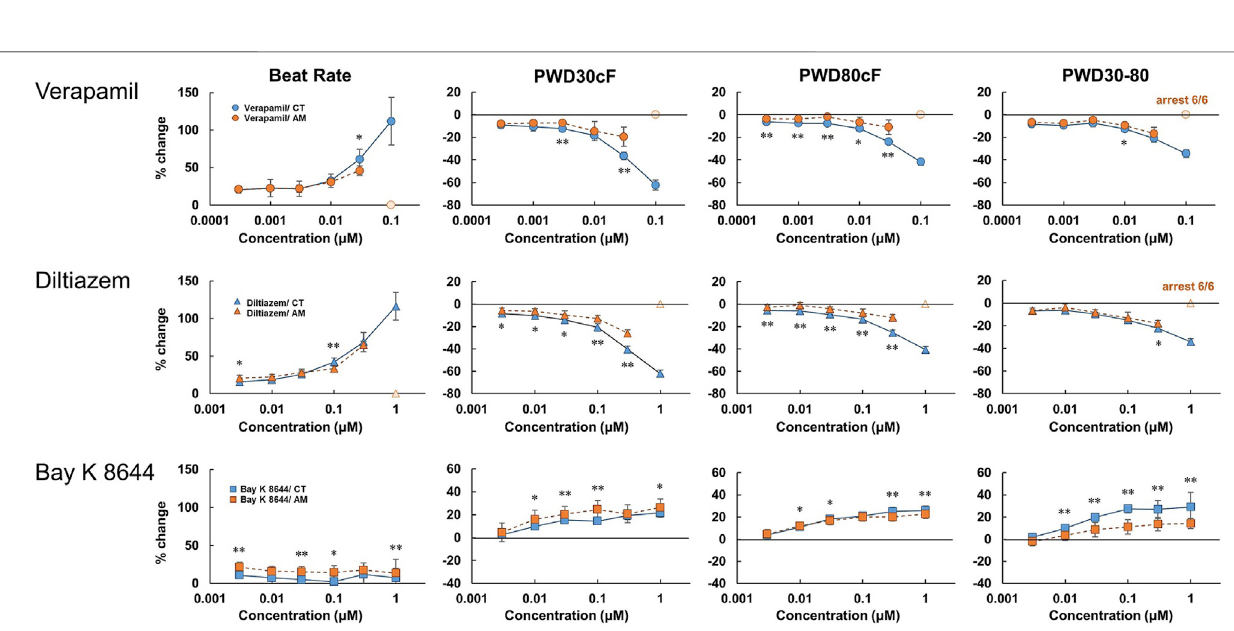
Frontiers in Pharmacology |